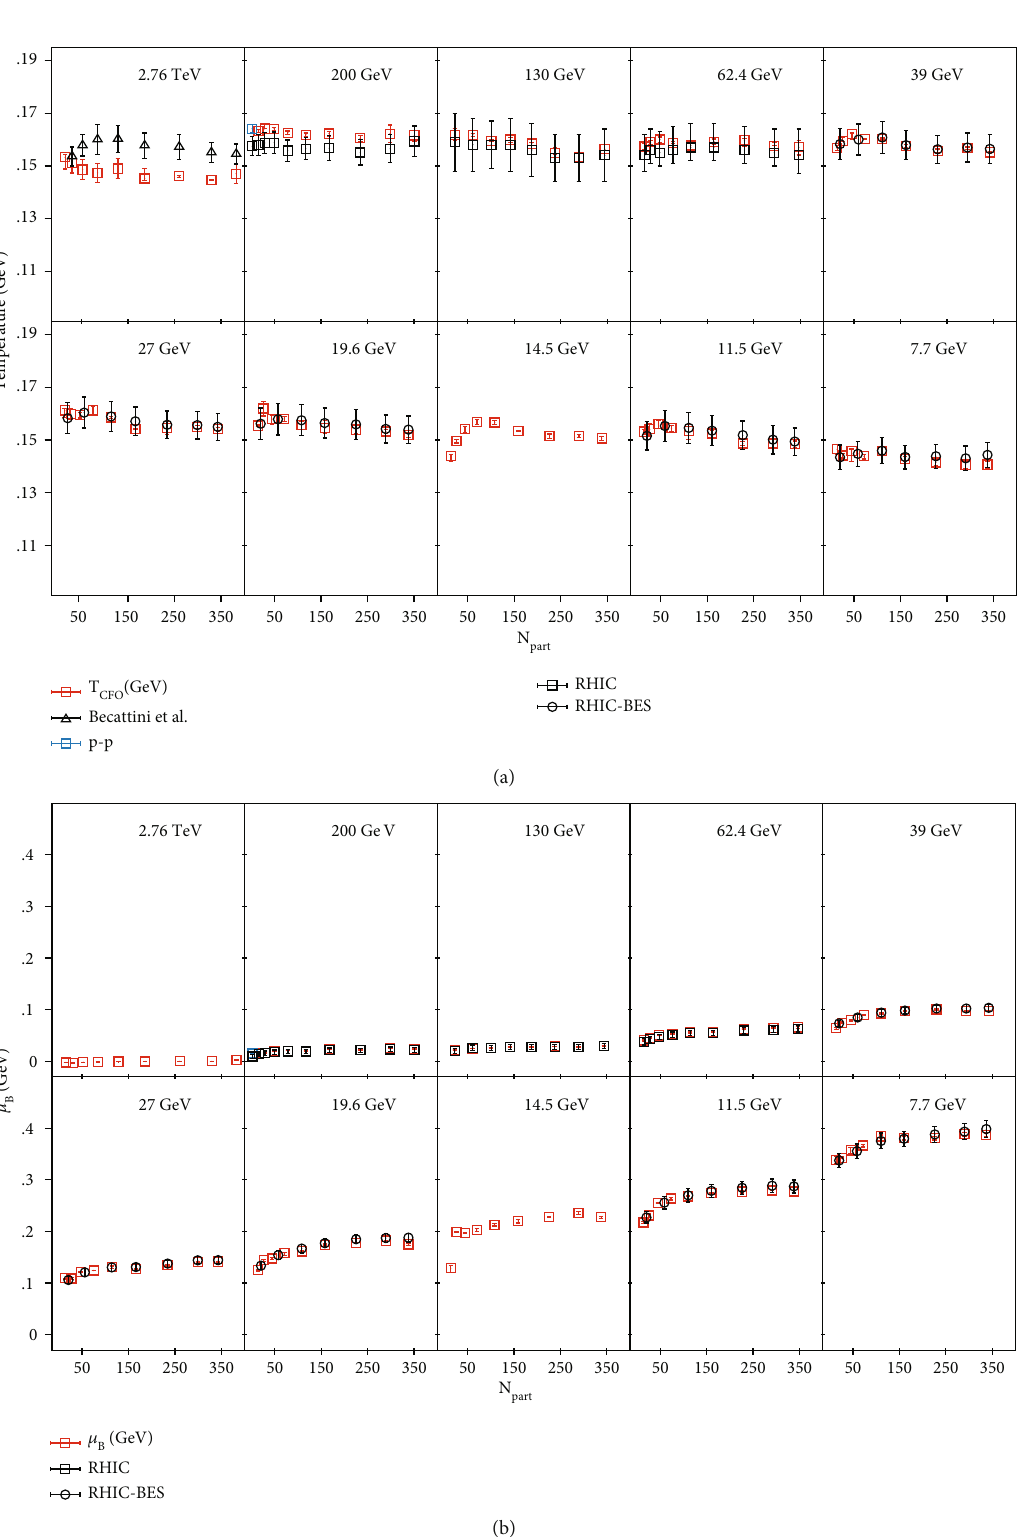
μ Figure 1: (Color online) variation of T with N part for representative collision energies. Each column stands for di ff erent collision CFO , B energy, ranging from LHC (2.76TeV) to RHIC-BES (7.7GeV). Most central collision ( 0 % − 5 % ) is denoted by the highest value of N part , lowest value denotes the peripheral collision ( 70 % − 80 % ). Red squares denote results for Pb-Pb at LHC and Au-Au at RHIC and BES. Blue square points analysis for p - p collision of RHIC-200GeV. Results from available literature have been included in the following Ref. [73] for LHC (black triangle), Ref. [6] for RHIC (black square), and Ref. [66] for RHIC-BES (black